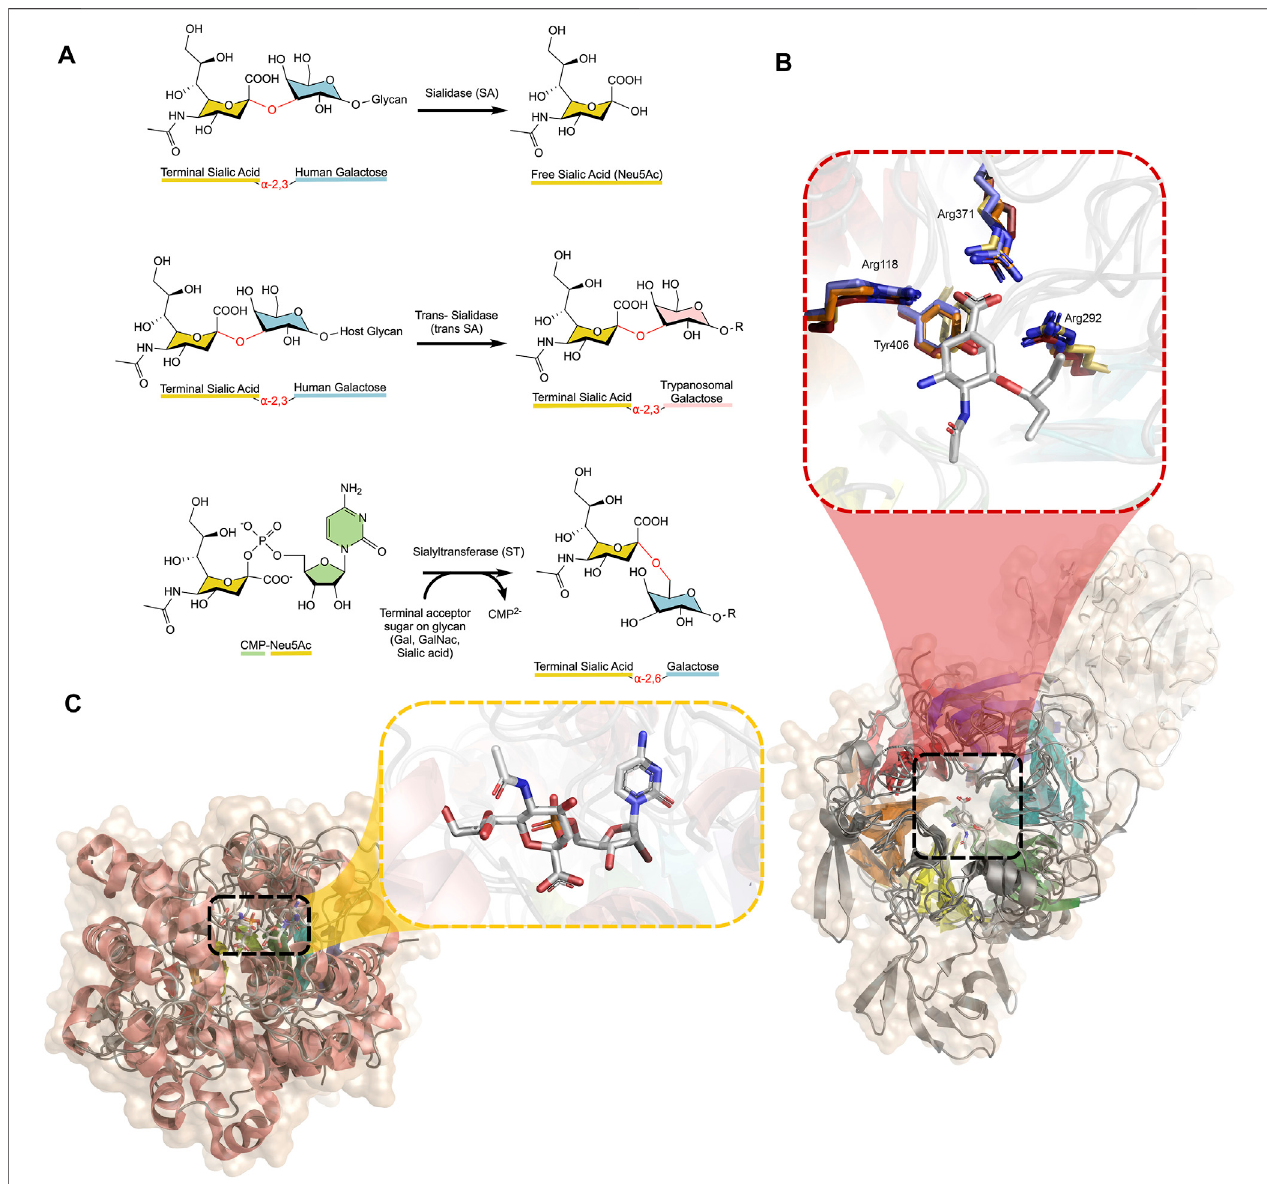
FIGURE 1 | (A) Reactions catalysed by SAs, trans-SAs, and STs, with glycosidic bonds broken or formed shown in red between each monosaccharide. SAs and STs act to hydrolyse or create different linkages ( α -2,3/ α -2,6/ α -2,8/ α -2,9) between the monosaccharides, depending on the speci fi c enzyme, while the trans-SA of the Trypanosoma family speci fi cally acts on α -2,3 linked sialic acids (B) Alignment of four SAs (In fl uenza N1, C. perfringens NanI, T. cruzi trans-SA, H. sapiens NEU2) displaying the β -propeller structure with approximate six-fold symmetry highlighted in rainbow colours. The trans-SA transfer domain is shown in white. The active site is enlarged, showing oseltamivir bound in the active site. The highly conserved position of active site residues of In fl uenza (yellow), C. perfringens (orange), T. cruzi (red), andHuman (blue)NAs,withcorrespondingnumberingfromin fl uenzaN1(PDB IDs3CL0,5TSP,2AH2,and1VCU,respectively)(Amayaetal.,2004;Chavasetal., 2005; Collins et al., 2008; Lee et al., 2017) (C) Alignment of three human STs (ST3-GalNAcII, ST6-Gal-I, and ST8-SiaIII) displaying the conserved Rossman β -sheet architecture common to all STs (rainbow coloured) (PDB IDs: 6APL, 6QVT, and 5BO6, respectively). The active site is enlarged, showing CMP-Neu5Ac bound (Volkers et al., 2015; Moremen et al., 2018; Harrus et al., 2020). Figures created using PyMOL and ChemDraw.